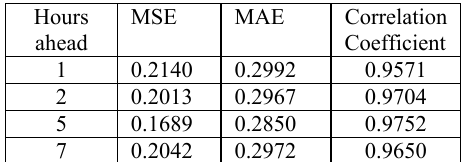
Table 1. Errors and correlation coefficients in case 1 for all scenarios.